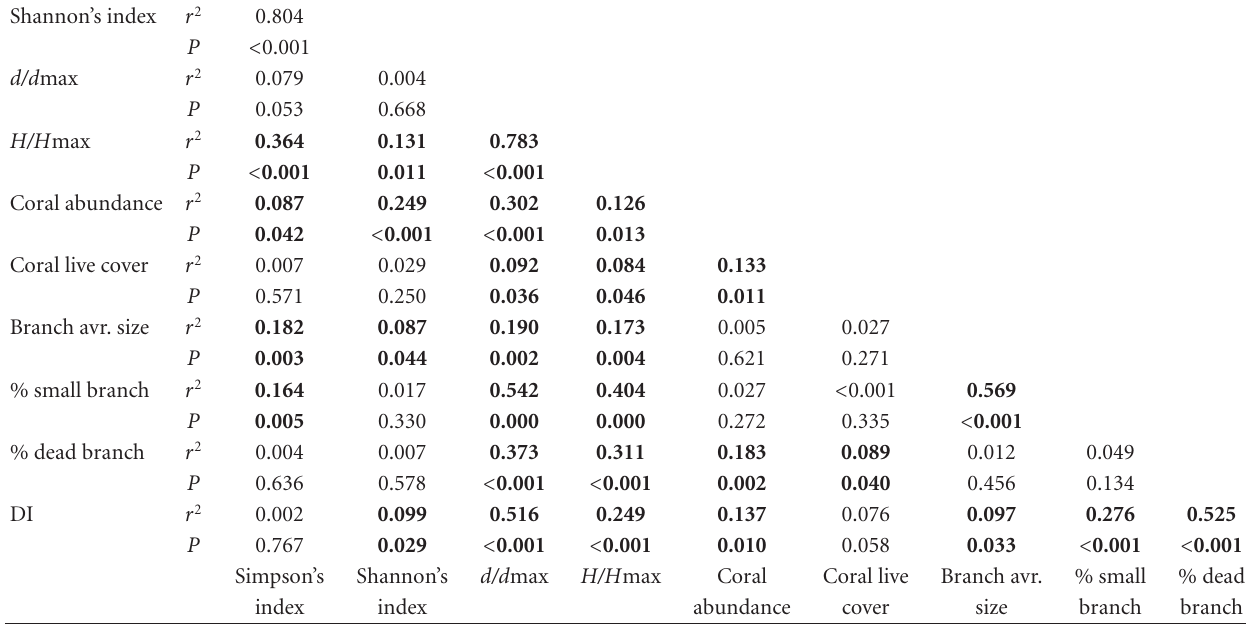
Table 4: Results of regression between the ecological indices calculated for each transect of the fourteen stations of young coral communities. In each square the top figure is r 2 and the bottom is the P value. Significant correlation ( P < 0 . 05) is marked in bold.